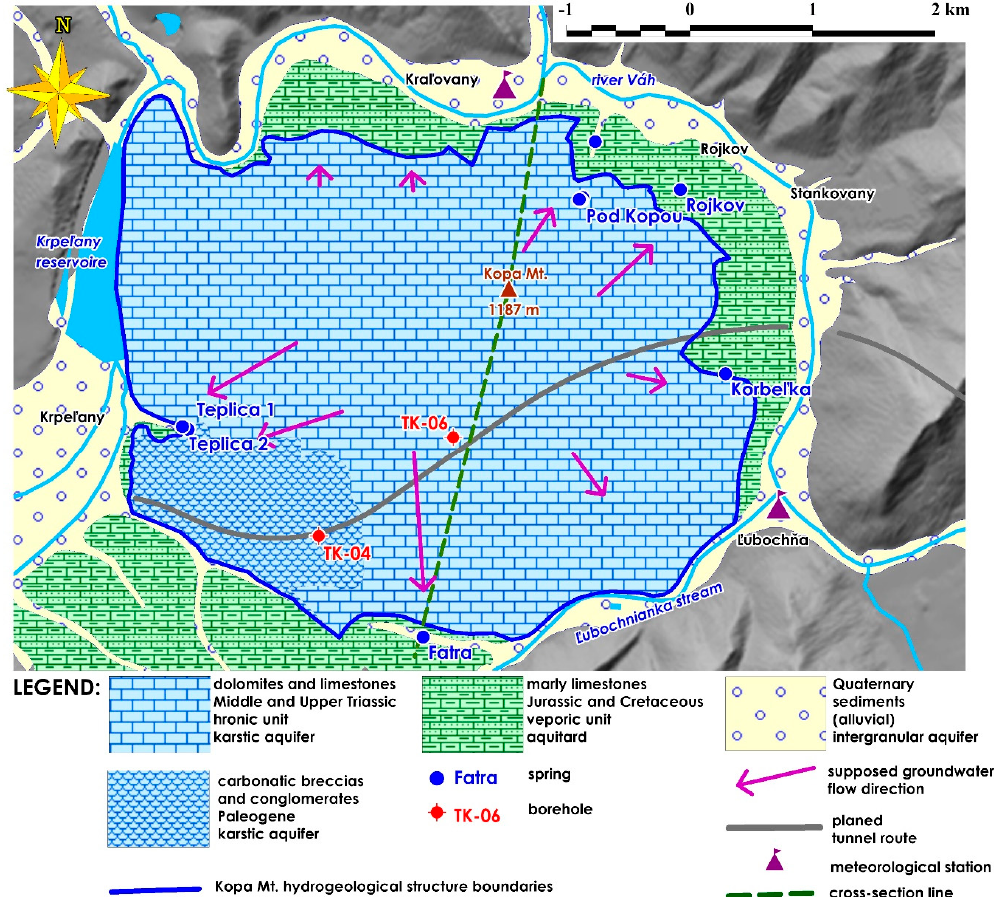
Figure 2. Aquifer of the Kopa Mt. hydrogeological structure in a simplified geological map.